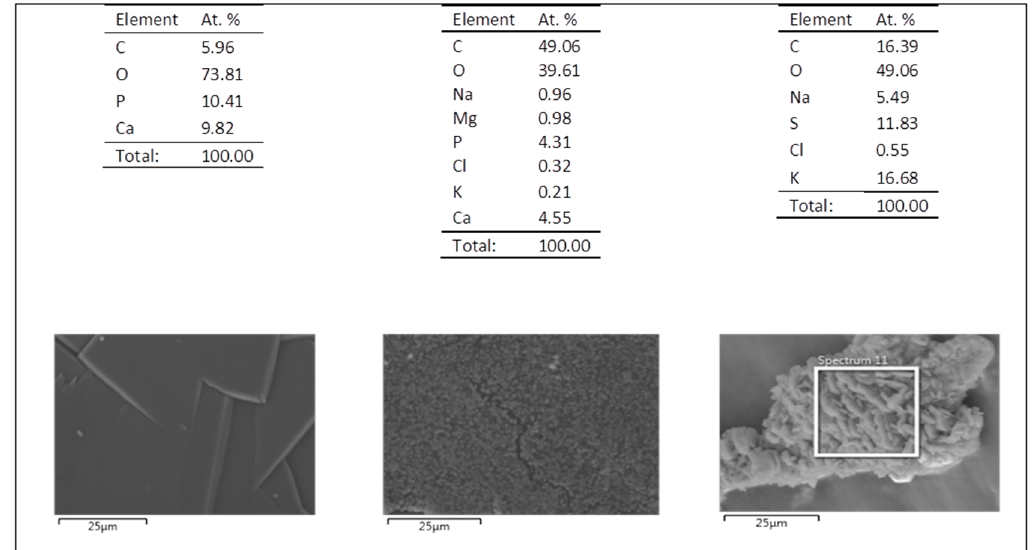
Figure 16. Chemical composition of three di ff erent precipitates formed at the surface of PP support after immersion in artificial urine for 21 days.